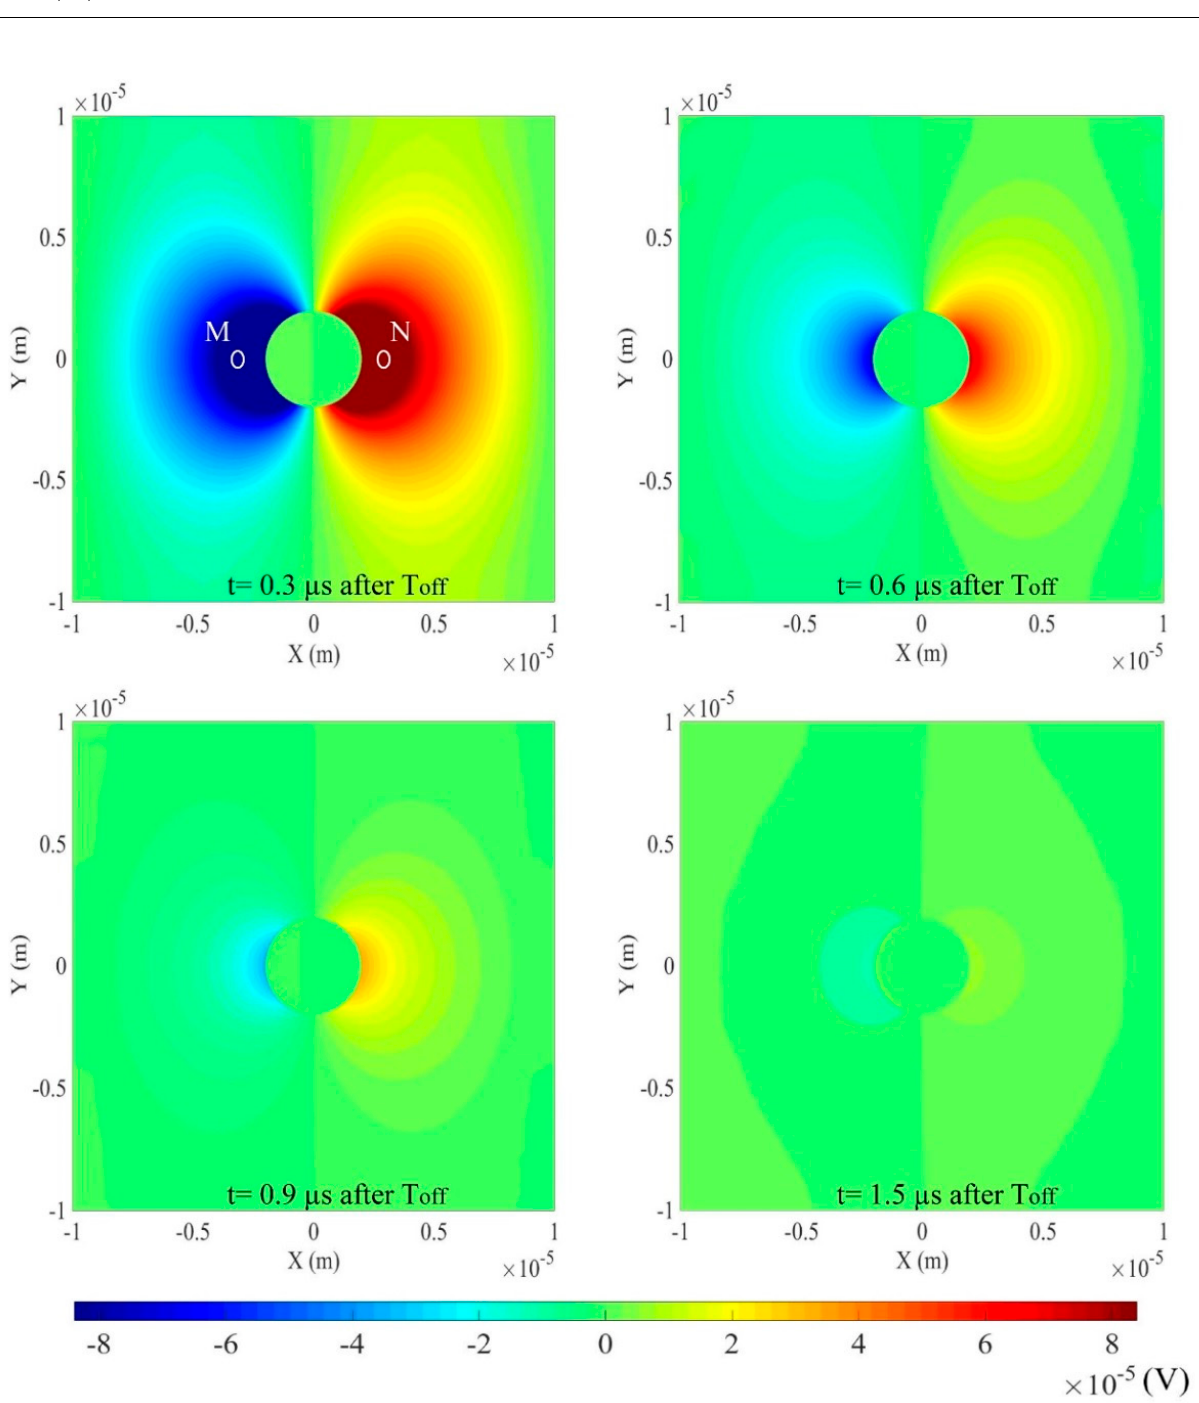
Figure 10. Secondary potential created after current injection during 150 ns. Electrolyte is KCl with concentration of 0.1 mol/L. The electrical dipole formed inside the grain appears clearly just after shutting down the current injection. The electrodes M and N correspond to the two voltage electrodes on which the potential difference is “measured”. The volume of the metal is determined by the surface fraction of the metallic body inside a square passing by M and N. Therefore, increasing the distance from these electrodes from the center of the particle is similar to a decrease in the volume fraction of the metallic particle.